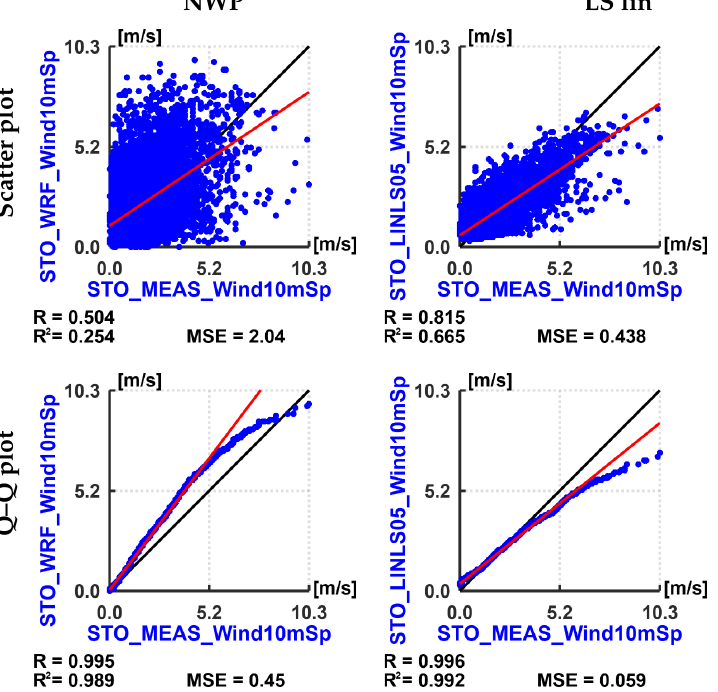
Figure 9. Scatter plots and Q–Q plots of wind speeds for Stolp meteorological station. The measure- ments are compared to the NWP model ( left ) and the linear regression with least squares model trained on May 2017 data ( right ). The shown LS lin model predictions are for the test data. The black line is the line of equality, and the red line is the least-squares linear fit of all the data